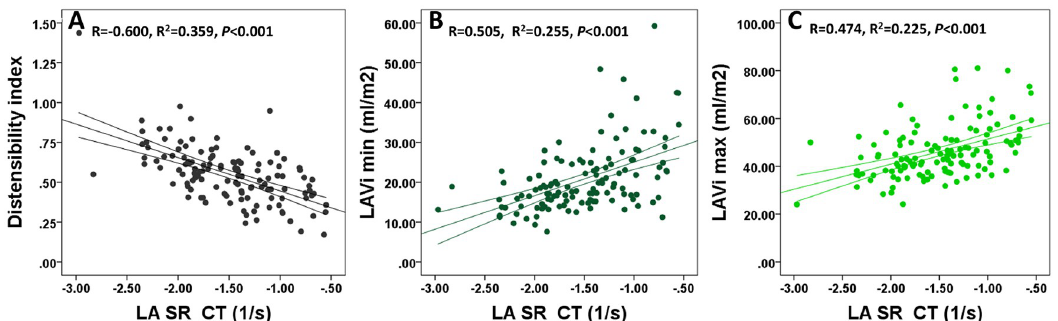
Fig 2. Correlations between LA pump function and other parameters. Correlations between LA pump function and distensibility index (Panel A), LAVi min (Panel B) and LAVi max (Panel C). LAVi, left atrium volume indexed; SR_CT, contractile strain rate.